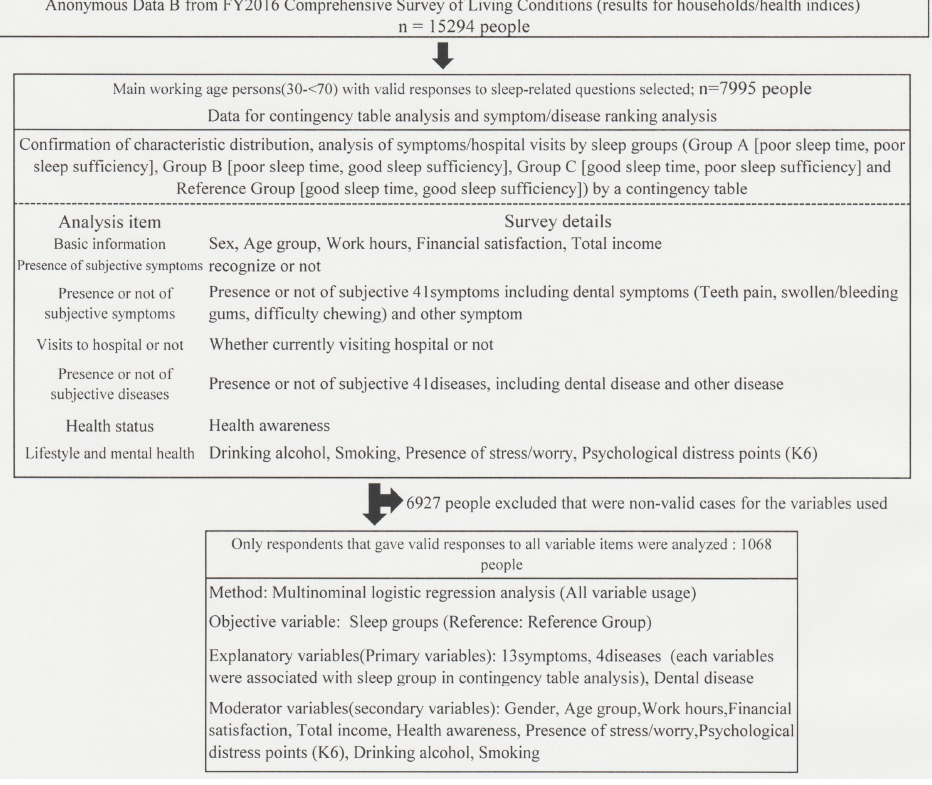
Figure 1. Flowchart of the data analysis in the present